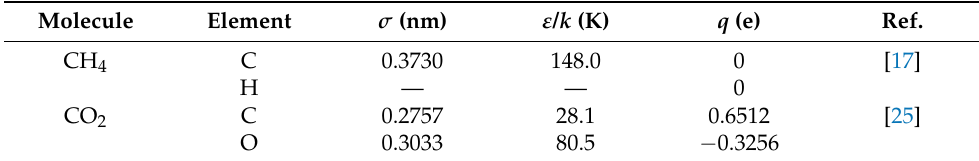
Figure 1. Atomistic models of CO 2 , CH 4 , and CHA-type zeolite. Table 2. Non-bonding interaction parameters of CH 4 and CO 2 .